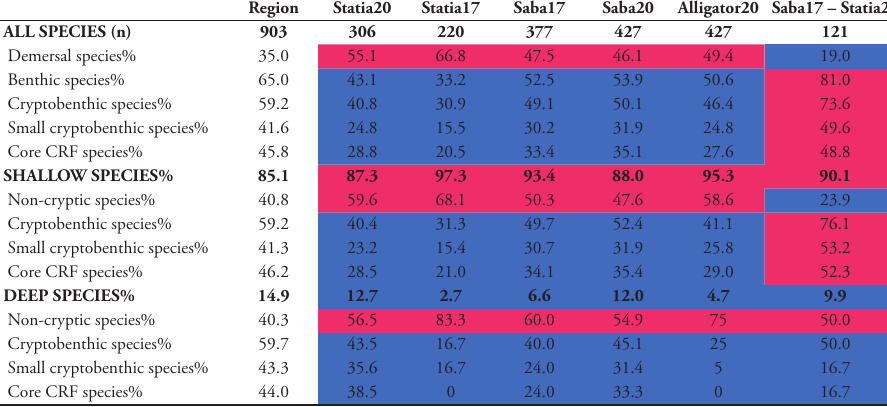
Table 2. Characteristics of assemblages of reef fishes at different locations in the Greater Caribbean region. Percentages of ecotypes in the entire regional fauna, the entire faunas from each local area, and within each of two depth subgroups refer to number of species as a % of the entire fauna and of each depth subgroup. Assemblages include those at Statia in 2017 and 2020 (Statia17 and Statia20), in the Saba EEZ in 2017 (Saba17), of species in the Saba17 fauna that are not currently known to occur at Statia (Saba17- Statia20), of the Saba EEZ in 2020 (Statia20 + Saba17), and of Alligator reef in 2020 (Alligator20). Small species are those with ≤ 10 cm maximum total length. Percentage values for individual sites that are greater than the regional value are shown in red, those below the regional value are in